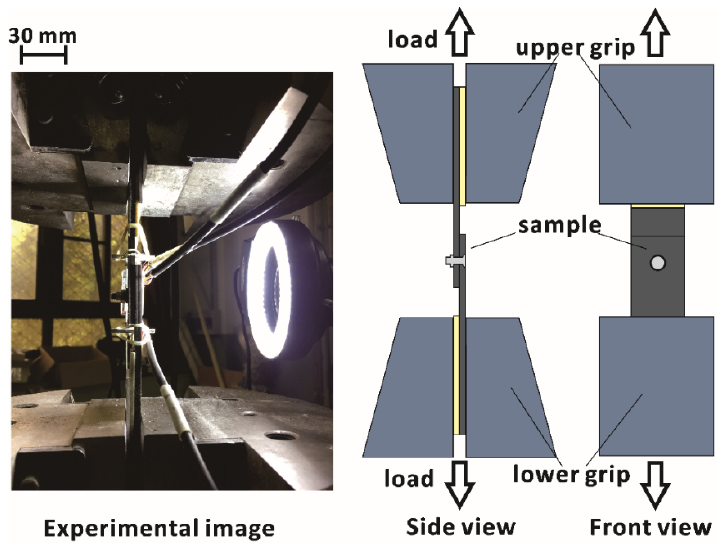
Figure 5. Schematic diagram of the tensile test.